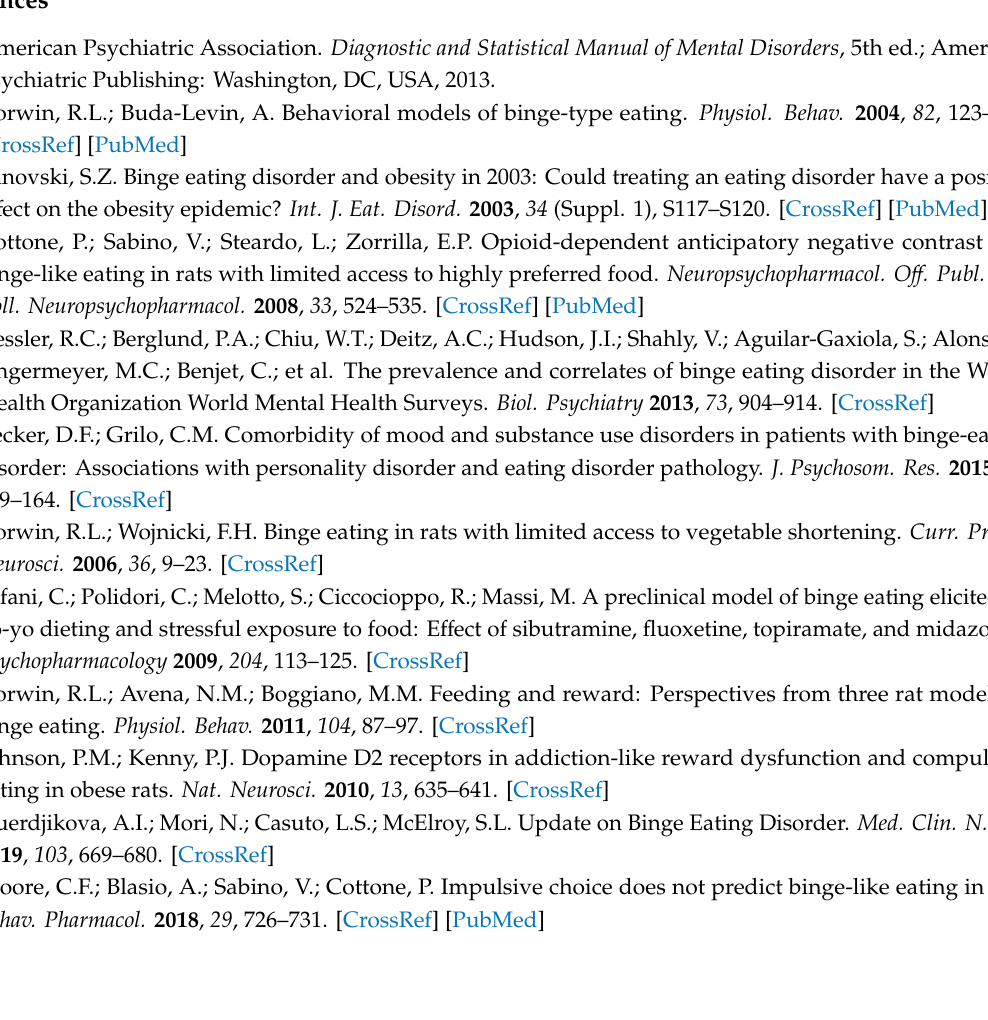
Table S1: Diets, Table S2: Composition of custom Bio-Serv F07679